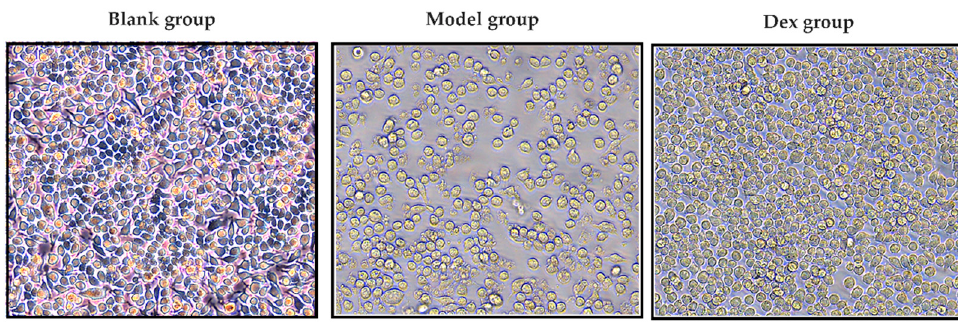
Figure 5 . Differentiation and identification of RAW 264.7 cells.